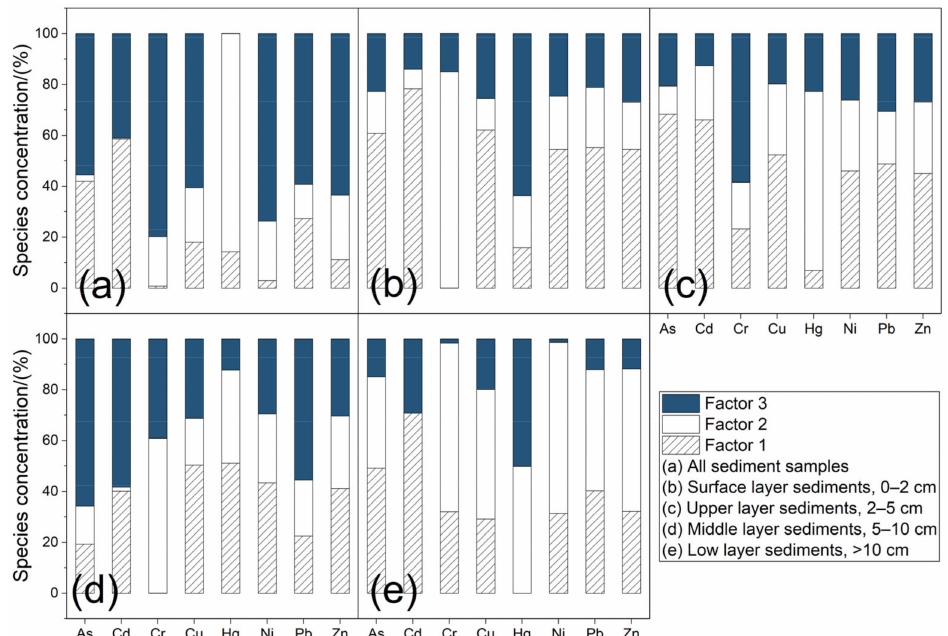
Figure 5. Source apportionment results for different heavy metals using the PMF model: Analysis results of the ( a ) overall contribution, ( b ) surface sediment layer, ( c ) upper sediment layer, ( d ) middle sediment layer, and ( e ) sediment layer below 10 cm. Factor 1: agricultural activities; Factor 2: traffic emissions and fuel combustion; Factor 3: industrial